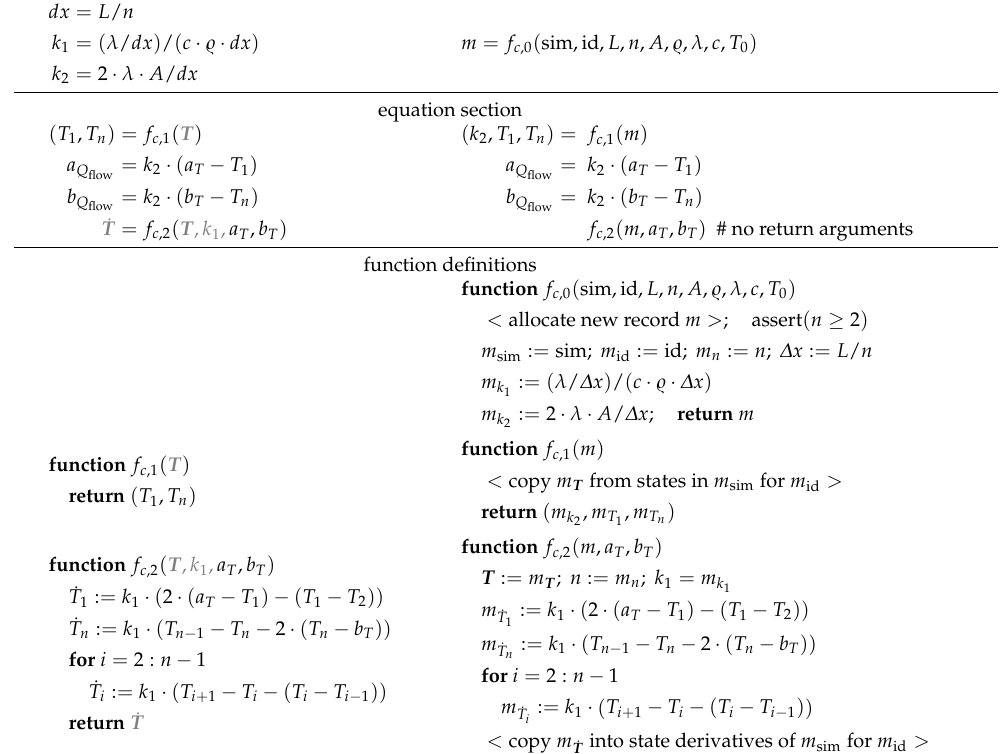
Table A1. Built-in component of an insulated rod with parameters L , n , A , (cid:36) , λ , c , T 0 , state vector T of length n (temperatures at rod volumes), connectors a , b on the left and right sides of the rod with potential variables a T , b T (temperatures), and flow variables a Q as component as built-in component (with mathematical functions) (with prog. lang. functions that have internal memory m